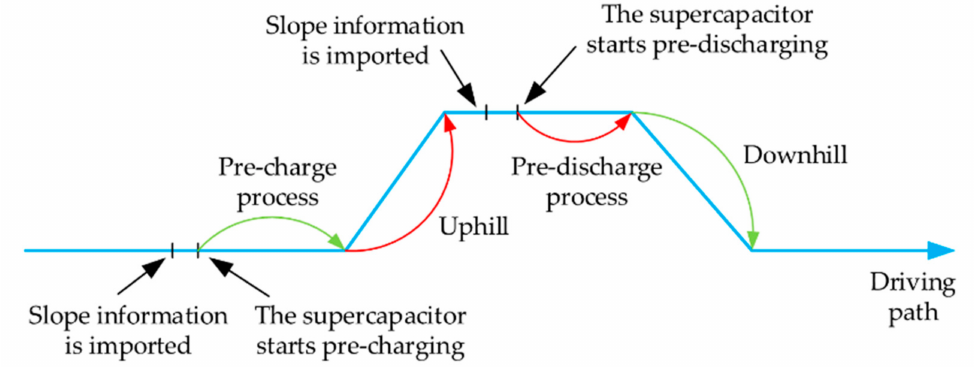
Figure 2. Energy distribution strategy based on slope